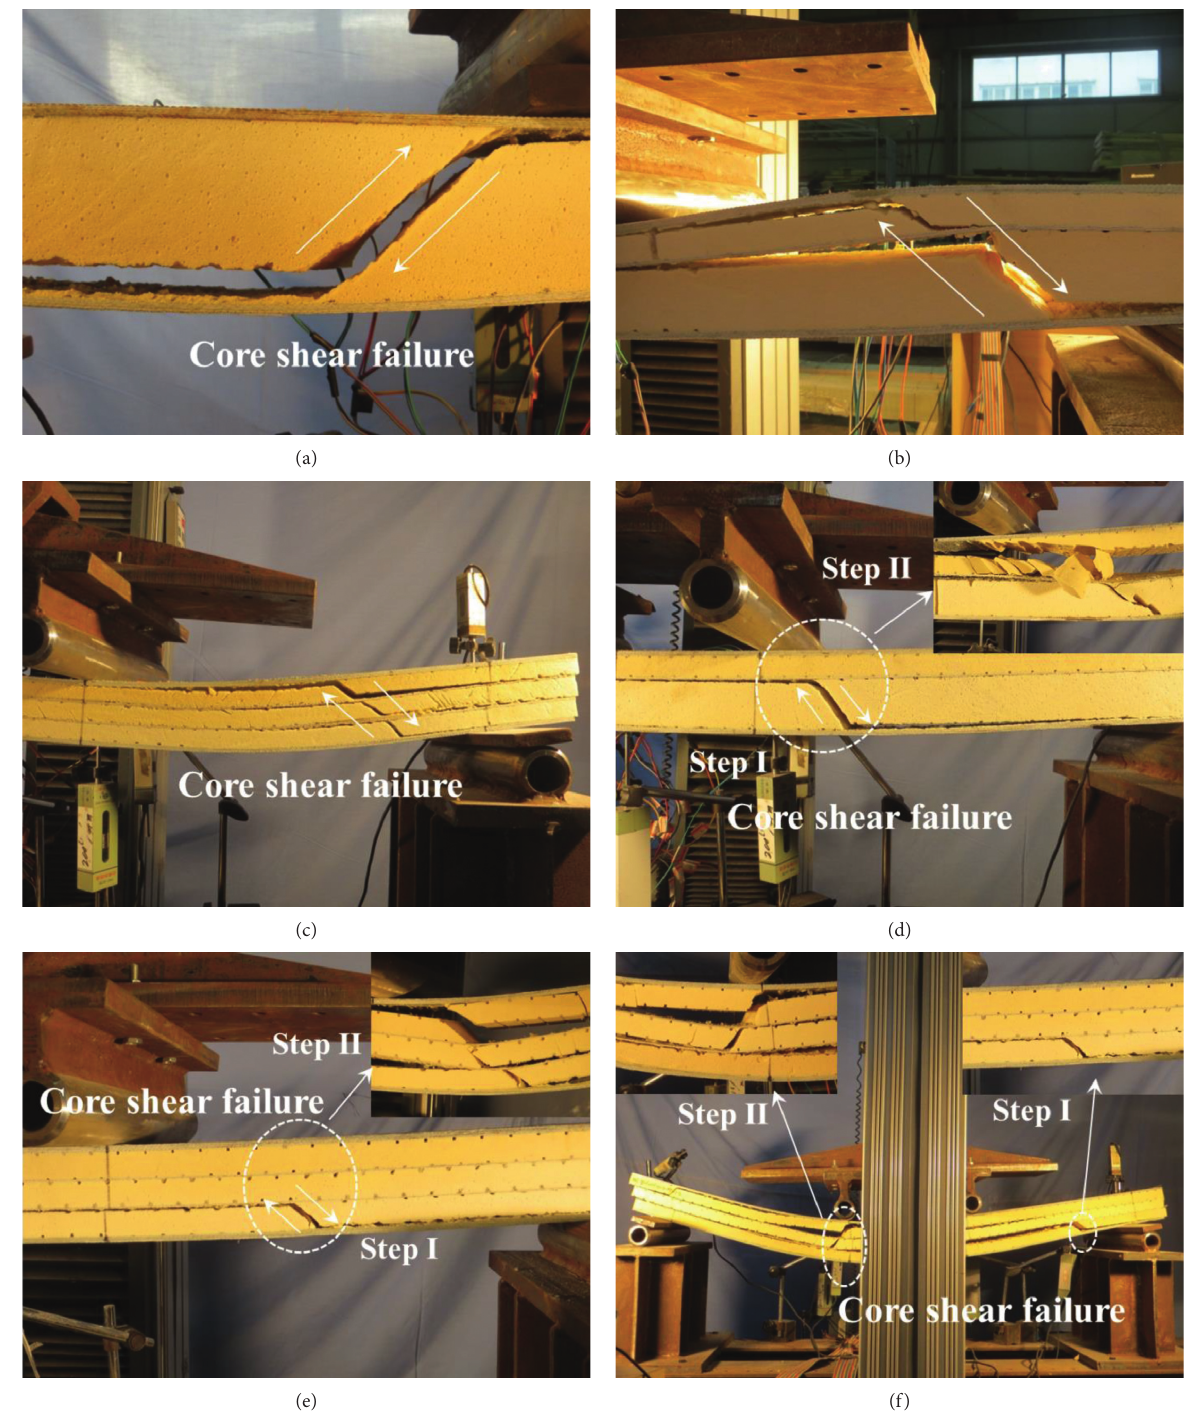
Figure 3: Failure modes of GHP specimens. (a) Specimen GHP-CON. (b) Specimen GHP-1-1. (c) Specimen GHP-2-1. (d) Specimen GHP- 1-2. (e) Specimen GHP-2-2. (f) Specimen